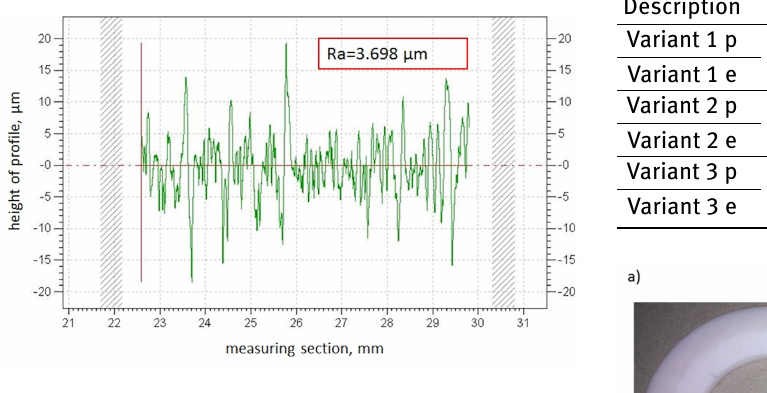
Figure 13: Profilogram of original seal variant 2 in equator direction